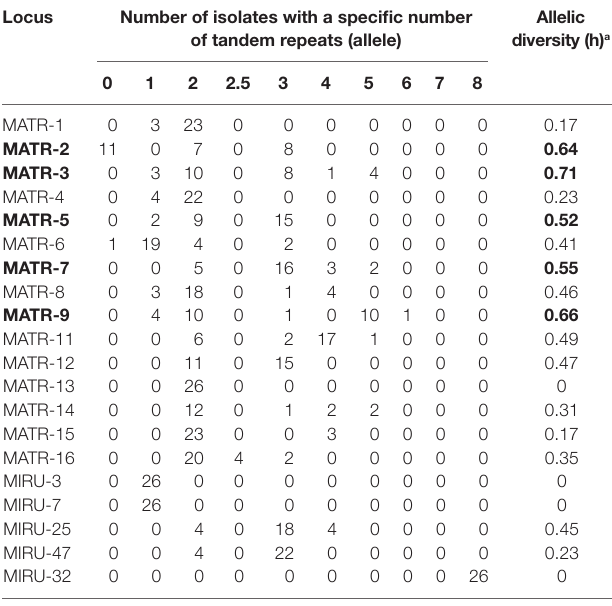
TaBle 3 | MATR/MIRU allelic distribution and diversity among 26 Swiss Mycobacterium avium subsp. hominissuis isolates evaluated in this study. locus number of isolates with a specific number of tandem repeats (allele)